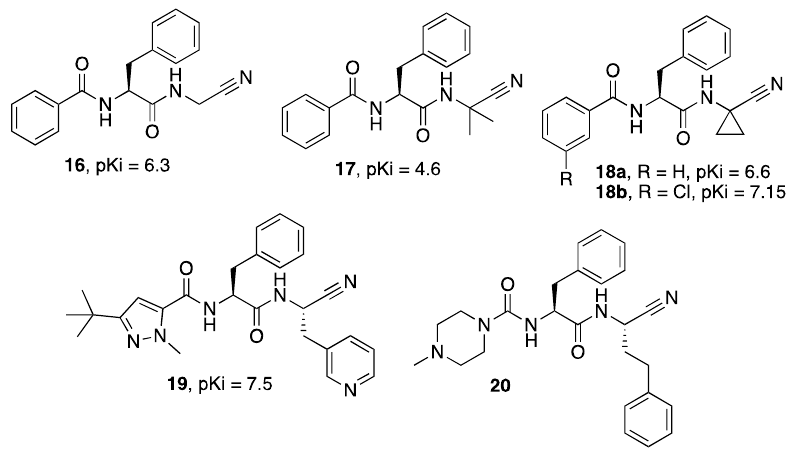
Figure 5. P2/P3-optimized dipeptidic inhibitors ( 16 – 20 ) of Cz.